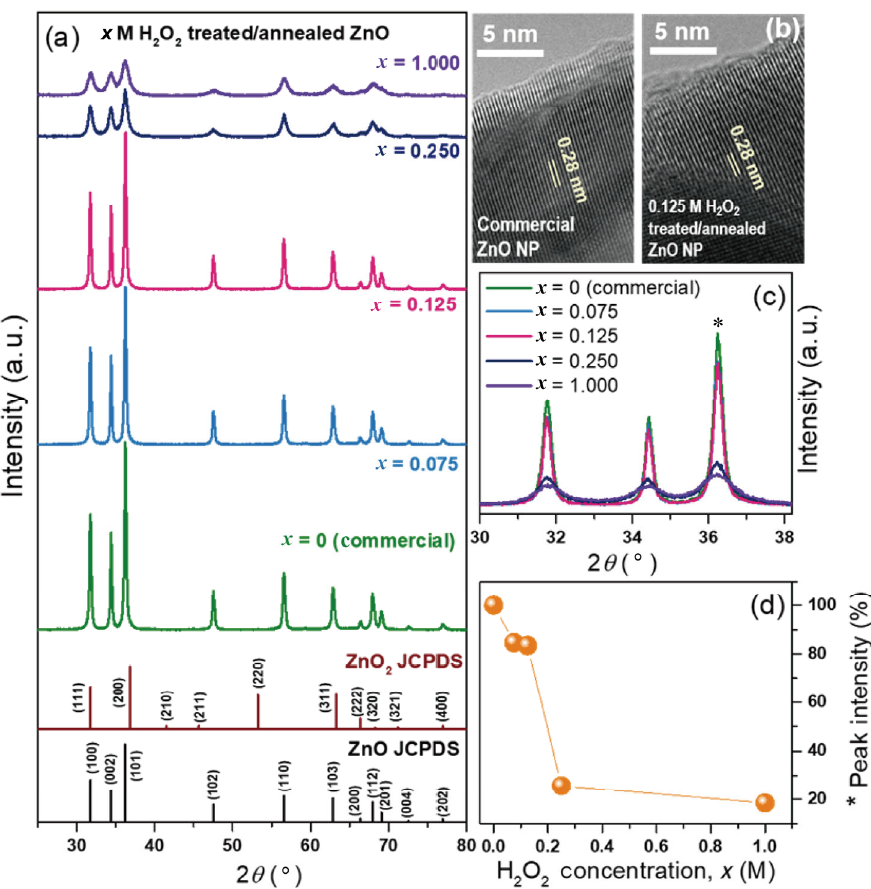
Fig. 2 (a) XRD patterns of commercial ZnO and x M H 2 O 2 treated/annealed ZnO ( x = 0.075, 0.125, 0.250, and 1.000) nanopowders. (b) TEM image of commercial ZnO NP (left) and 0.125 M H 2 O 2 treated/annealed ZnO NP (right). (c) Magnified three main peaks of the prepared ZnO samples. (d) Intensity of the first main peak (*) as a function of H 2 O 2